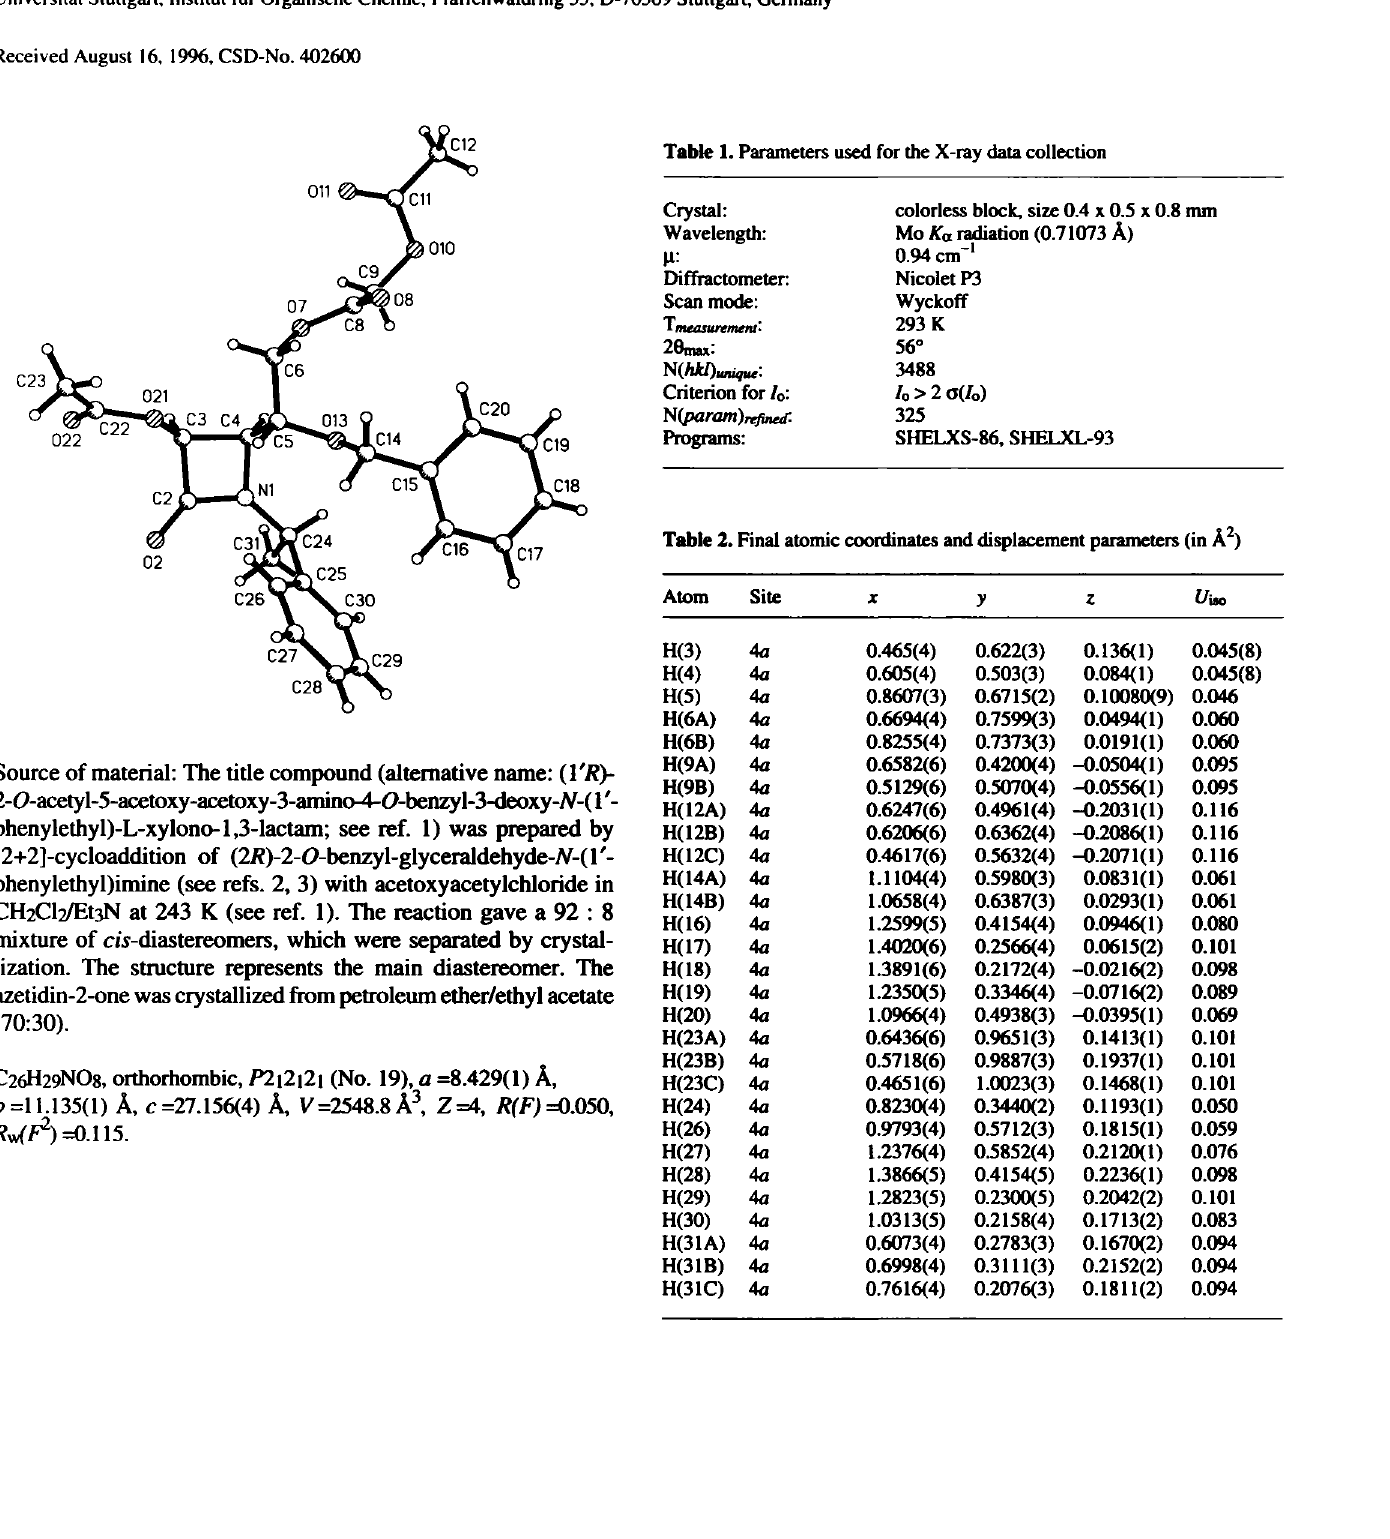
Table 1. Parameters used for the X-ray data collection Crystal: